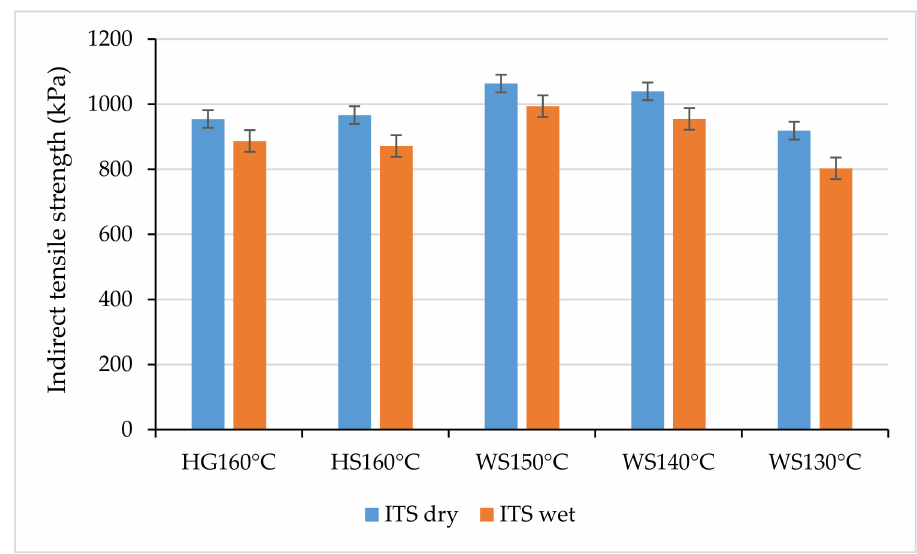
Figure 6. Indirect tensile strength and the standard error bars of the asphalt mixes.